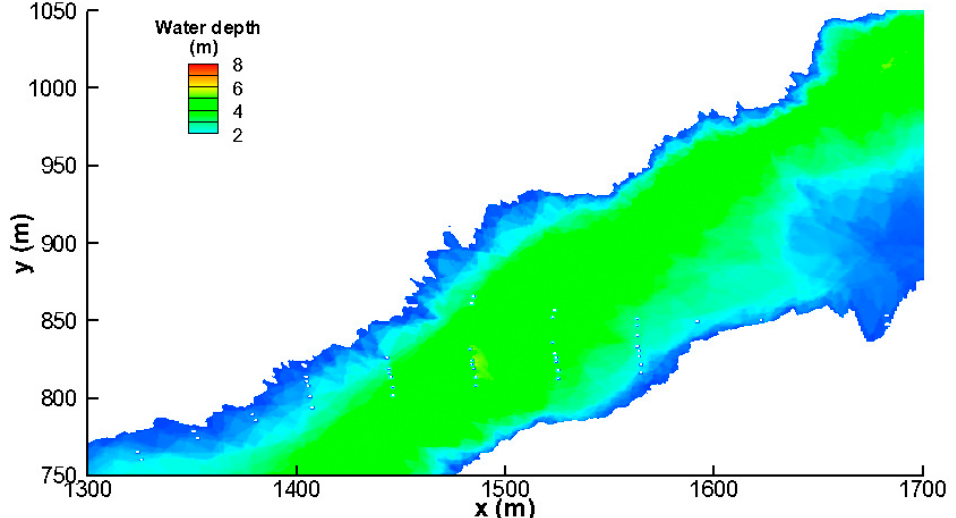
Figure 7. Distribution of water depth near the Fengxian Bridge for 10-year flood conditions (circles denote bridge piers).